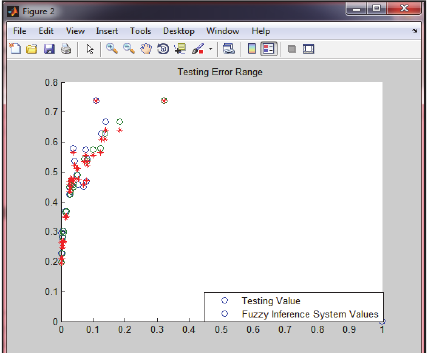
Fig. 9. Displaying real values and the